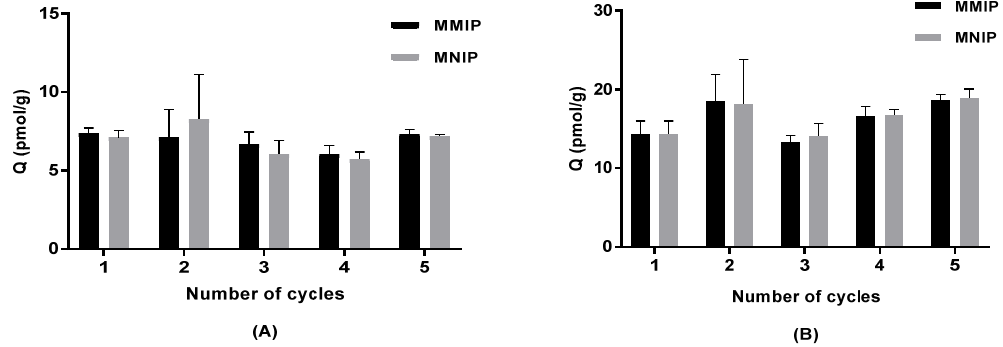
Figure 6. Adsorption on thermally synthesised magnetic polymers that were washed and cycled in model wine (mean ± SD, n = 3) for ( A ) 20 ng/L IBMP and ( B ) 50 ng/L IBMP.